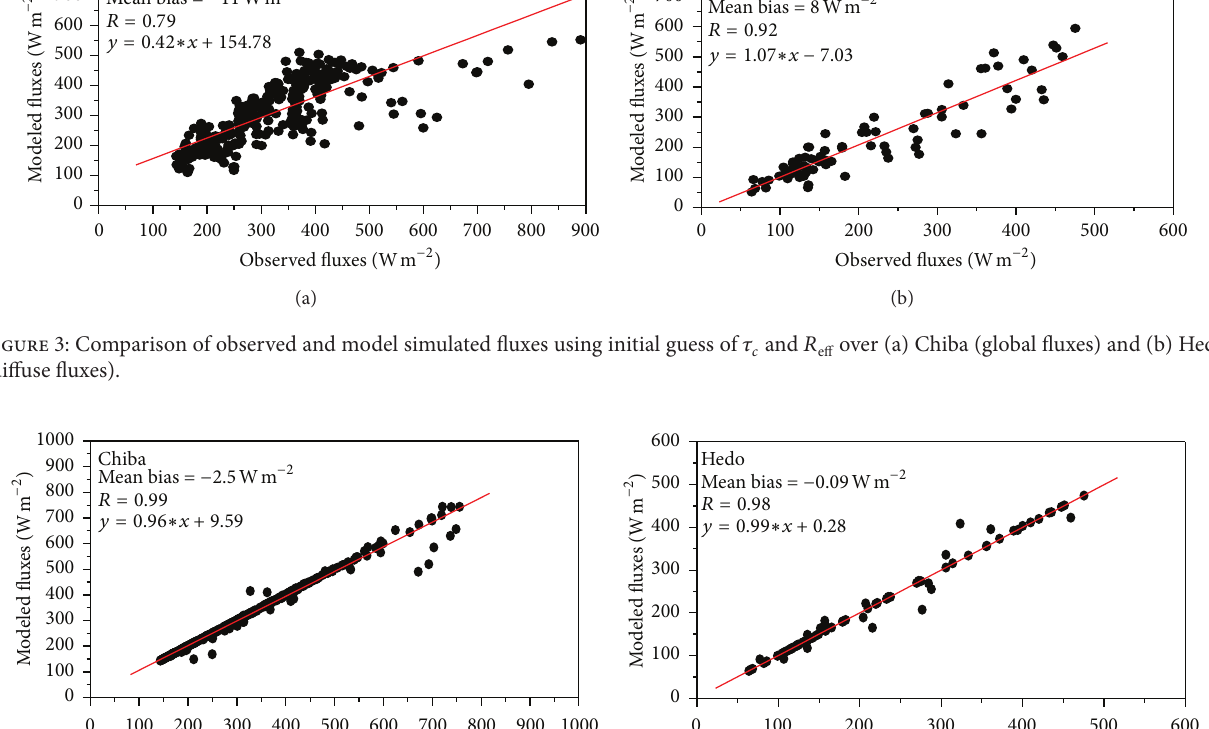
over (a) Chiba (global fluxes) and eff